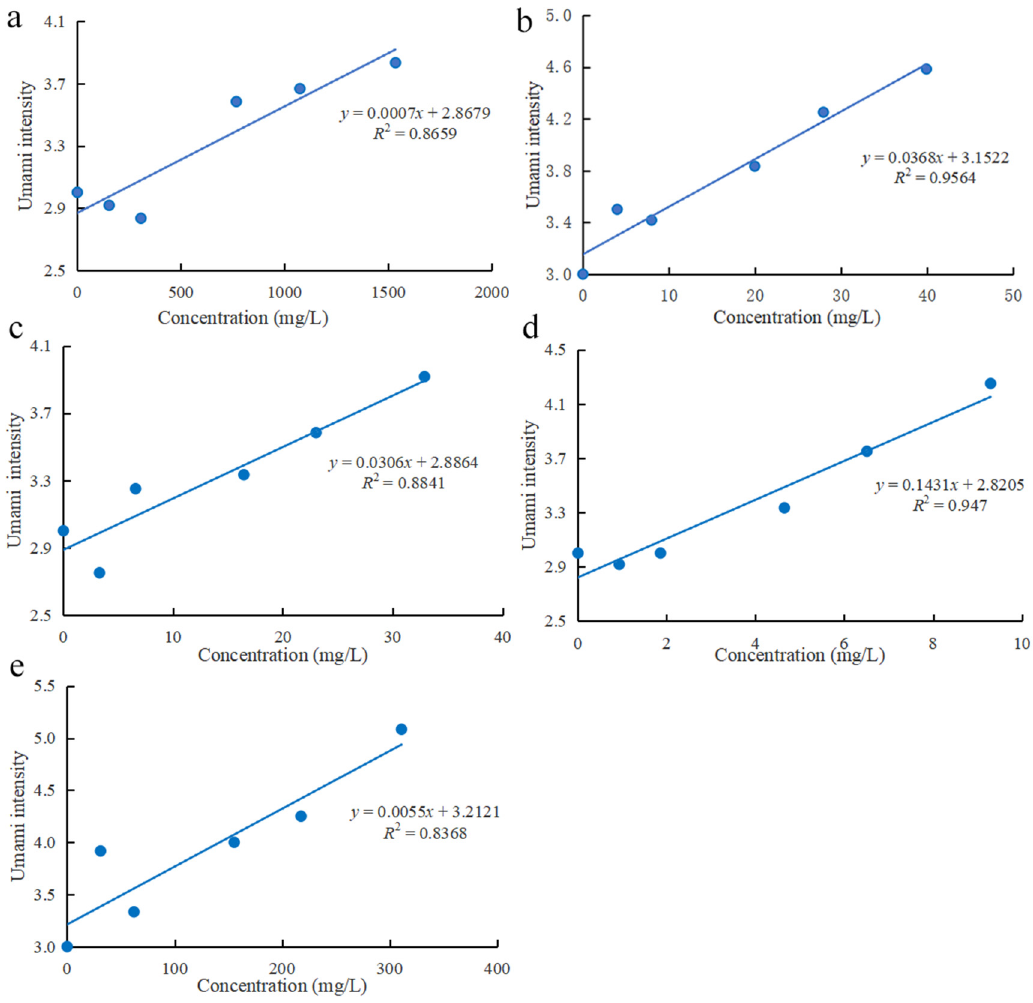
Figure 5. Sensory results of compounds added to monosodium glutamate solution ( a ) Thr; ( b ) Asp; ( c ) lactic acid; ( d ) citric acid; ( e ) succinic acid.